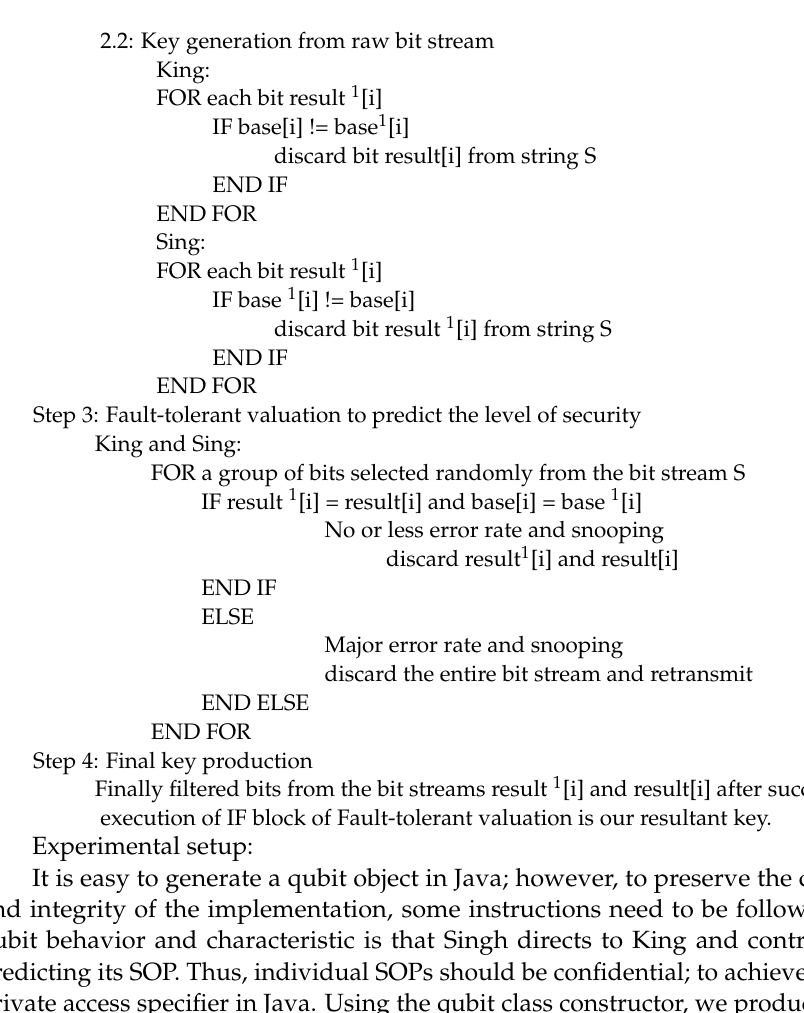
Table 3. BB84 qubit SOP-based encrypting design. 2020